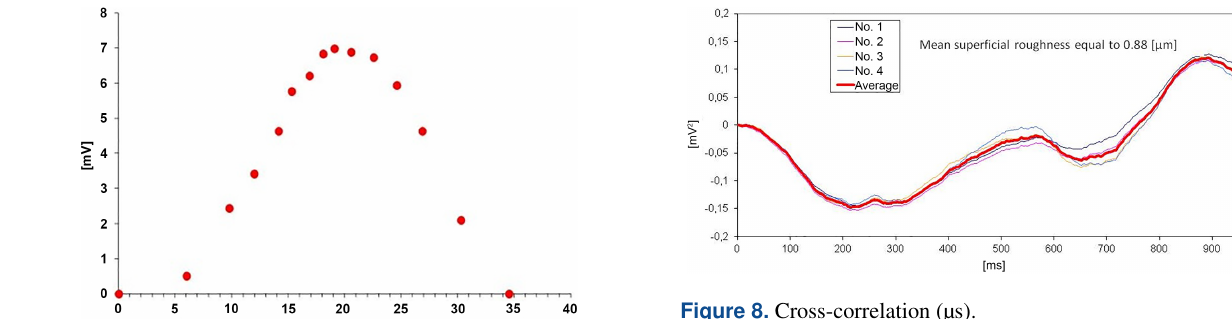
Figure 8. Cross-correlation (µs).